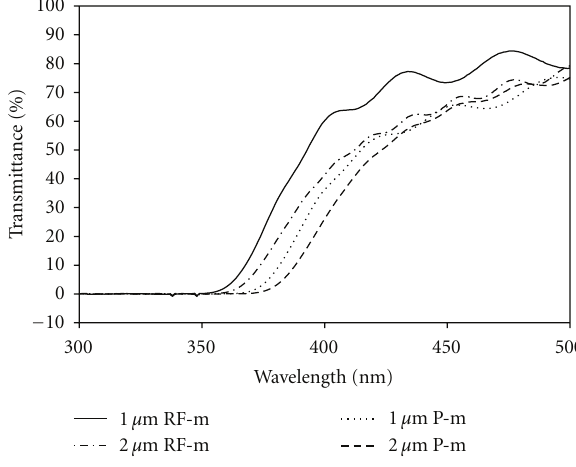
Figure 11: Optical transmission for the ZnO:Al 2 O 3 films of two di ff erent thicknesses grown by two di ff erent